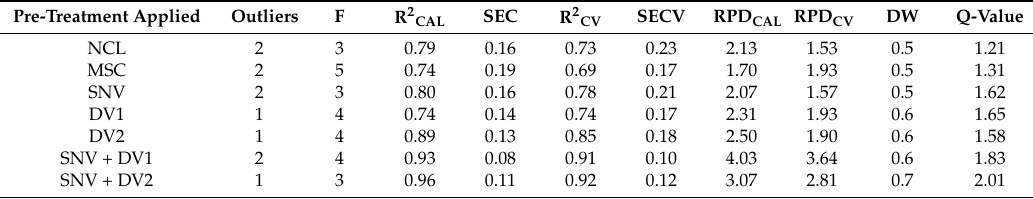
Table 3. The optimal PLS model prediction results for TOC and the corresponding statistical parameters of the various single and combined pretreatments for the WS set. (NCL = normalization by closure; MSC = full-multiplicative scatter correction, SNV = standard normal variate; DV1 = 1st derivative; DV2 = 2nd